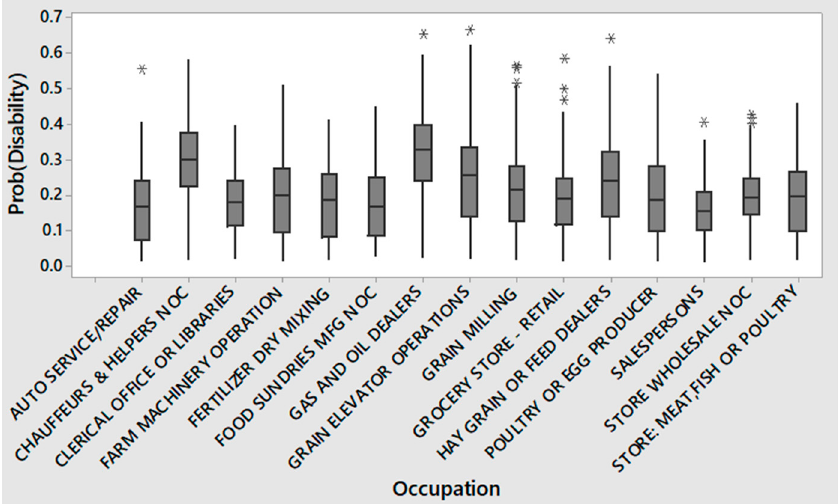
Figure 5. Boxplot of disability post-incident state with respect to occupation. (* shows the outlier data points; NOC: not otherwise classified).